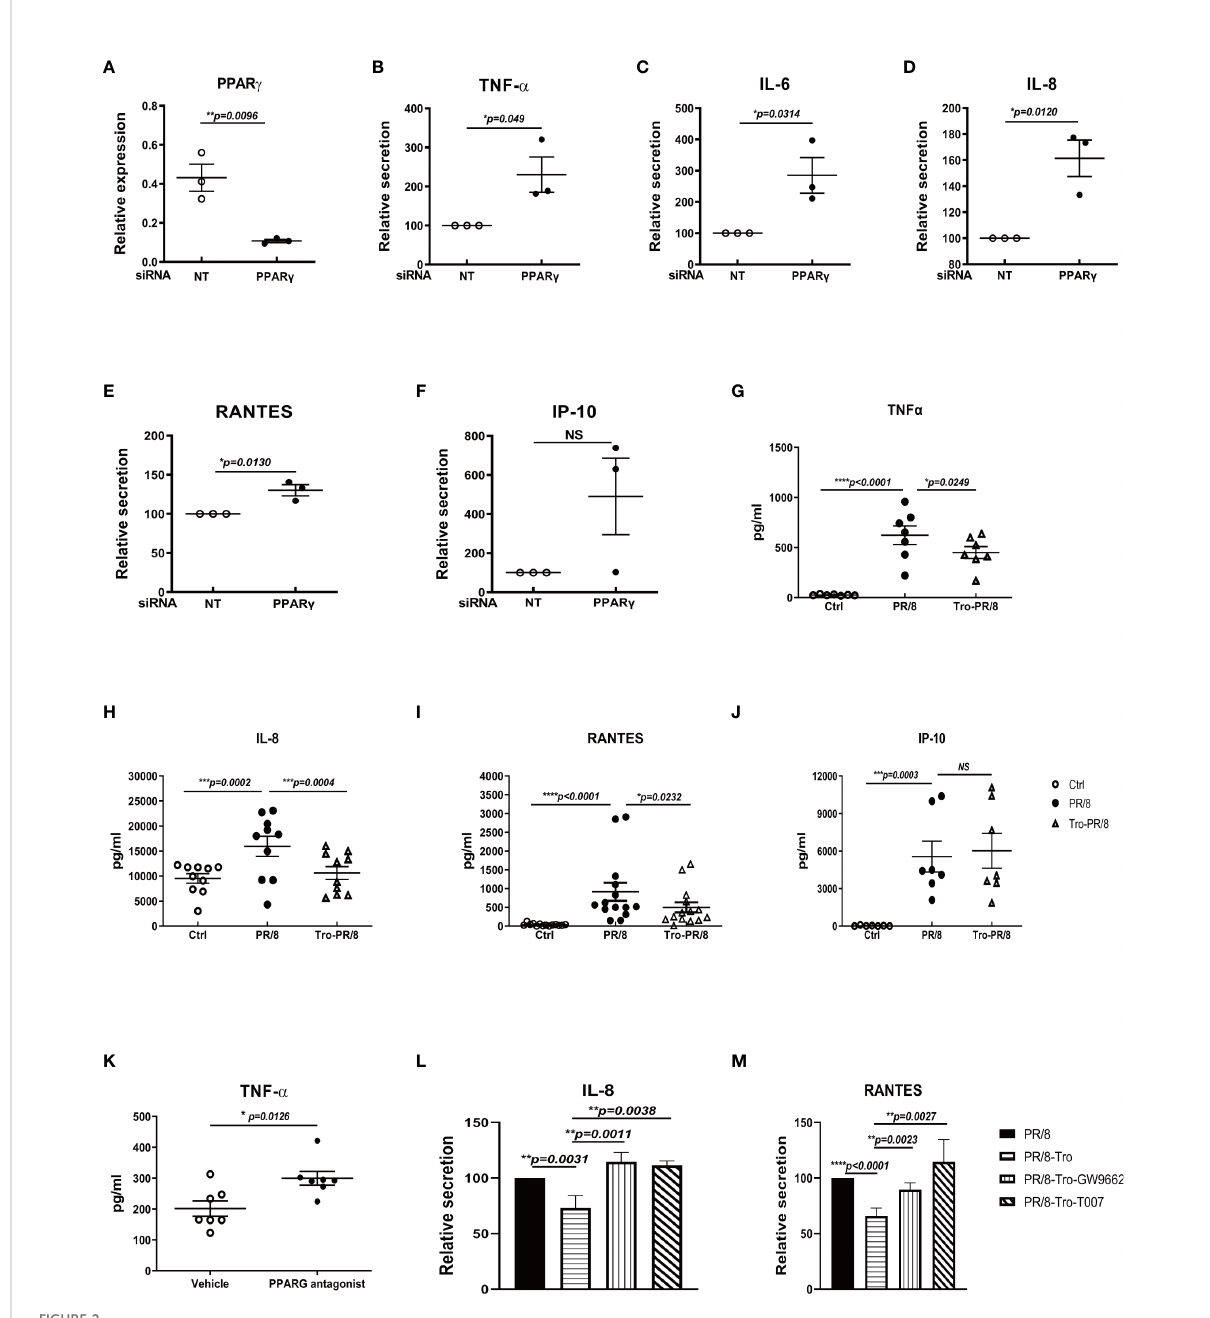
FIGURE 2 PPAR g is critical for controlling in fl uenza virus-induced proin fl ammatory response in human AMs. Human AMs isolated from three donors were transfected with PPAR g speci fi c siRNA or nontarget control siRNA(NT) 48 h before infections with PR8(MOI=1). At 24 h after infection, RNA(A-F) was extracted for examining PPAR g gene expression, and cell-free culture supernatants were collected to detect cytokines using DuoSet ELISA kits from R&D Systems. (A) PPAR g mRNA level. (B) TNF a . (C) IL-6. (D) IL-8. (E) RANTES. (F) IP-10. (G – J) For the experiment with PPAR g agonist, troglitazone (5 m M) (Sigma, St Louis, MO) in human AMs, was given right after infection. PPAR g antagonist T0070907 or GW9662 (Sigma) were given 1h before infection. At 24 h after infection, cell-free culture supernatants were collected to detect cytokines using DuoSet ELISA kits from R&D Systems. (G) TNF a . (H) IL-8. (I) RANTES. (J) IP-10. Isolated human AMs were treated with PPAR g agonist, troglitazone (5 m M) in human AMs right after PR/8 infection. PPAR g antagonist T0070907 or GW9662 (Sigma) were given 1h before infection. After infection, cells were treated with agonists or antagonists for another 24 h. At 24 h after infection, cell-free culture supernatants were collected to detect cytokines using DuoSet ELISA kits from R&D Systems. (K) TNF a . (L) IL-8. (M) RANTES. Unpaired t test was applied for comparison of two groups, while one-way ANOVA was used for comparison of more than two groups. ns means no signi fi cance. *p < 0.05, **p < 0.01, and ***p <